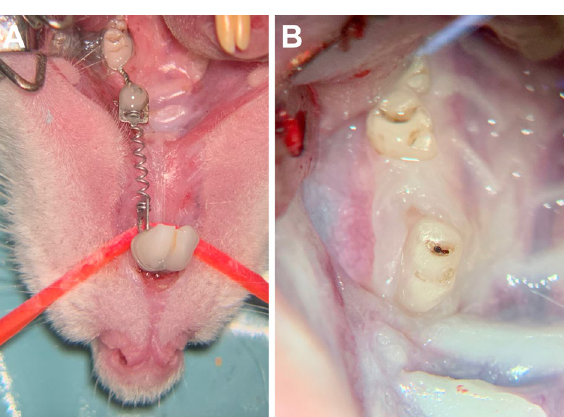
Figure 3. ( A ) Applied orthodontic appliance based on a 0.14 N nickel–titanium closed coil tension spring fixed between the first molar and the incisors using tension springs after conditioning of the teeth through acid etching using 39% phosphonic acid and bonding agent and dental composite (magnification × 4). ( B ) Anterior moved first molar after 8 weeks of orthodontic tooth movement (magnification ×